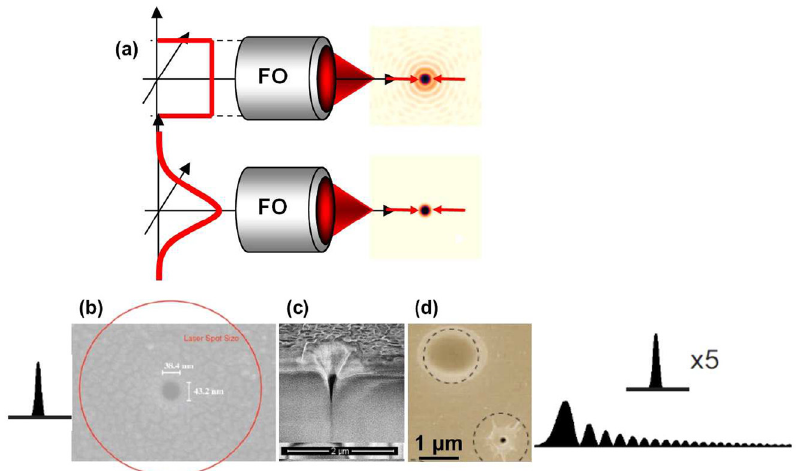
Figure 2: (a) Focusing a beam through an optical system. (b) Near-threshold focusing on a glass substrate. At the tip of the Gaussian beam profile, structures smaller than the waist are obtained. Reprinted with permission from a study by Joglekar et